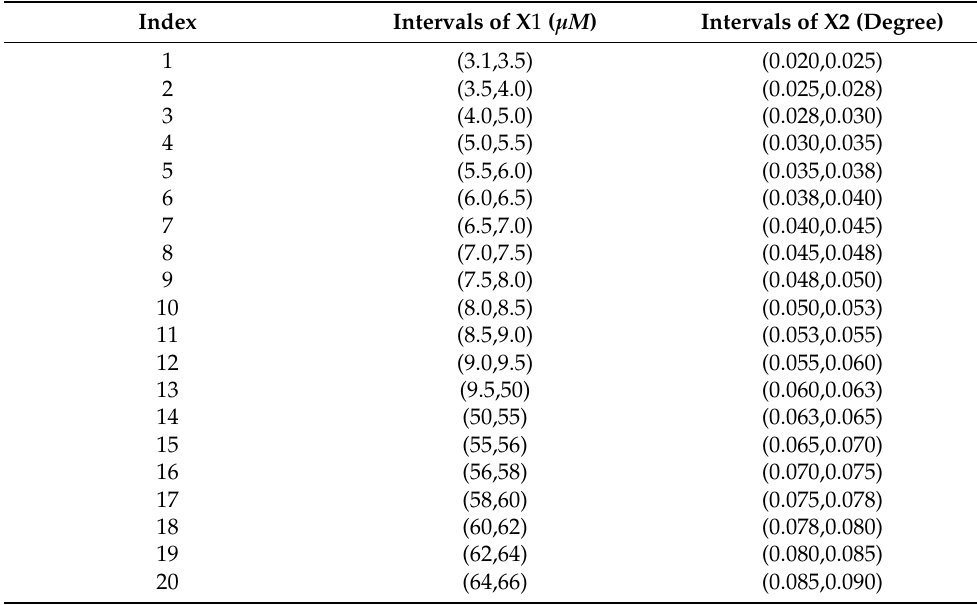
Table 13. Shows 40 intervals corresponding to attribute x1 and attribute